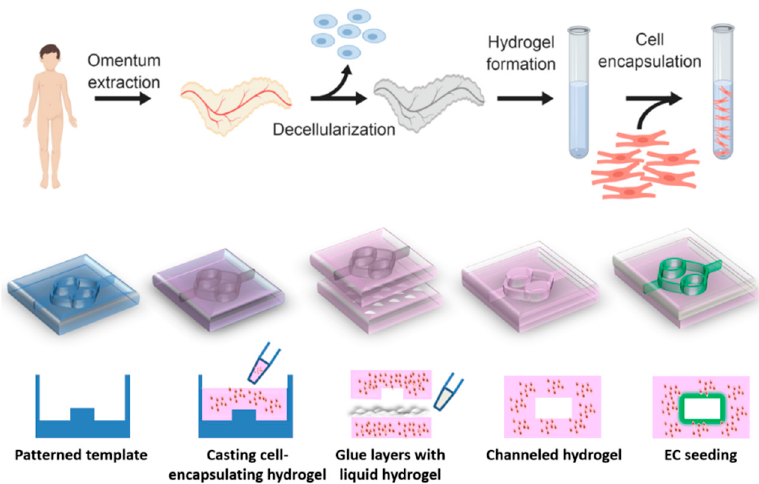
Figure 1. Schematic overview of the concept. Omental tissue is isolated from the patient and undergoes a quick decellularization process to produce omentum-based thermoresponsive hydrogel. The hydrogel is mixed with cardiac cells and then patterned. Two solidified seeded-layers are integrated together using the liquid form of the hydrogel, to create open lumens, which are later seeded with endothelial cells to create a vascularized cardiac tissue.